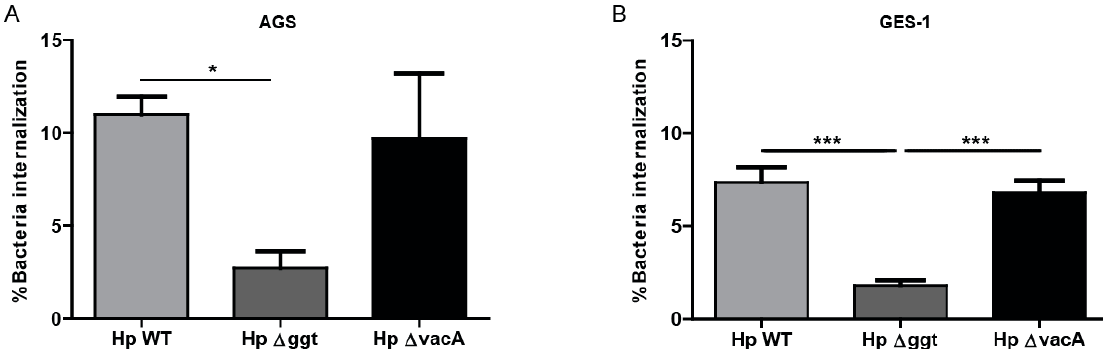
Figure 5. Loss of HpGGT decreases H. pylori internalization in gastric cells. AGS and GES-1 cells were infected with H. pylori wild type (HpWT) and the isogenic mutants Hp ∆ ggt and Hp ∆ vacA (lacking gamma-glutamyltranspeptidase and vacuolating toxin, respectively) at a multiplicity of infection (MOI) of 100 for 6 h. H. pylori internalization was evaluated using the colony unit forming assay. After infection, cells were treated with gentamycin (200 μ g/mL) for 1 h in order to eradicate extracellular bacteria. The percentage of intracellular viable H. pylori is shown. These data represent the mean ± the standard error of the mean (SEM) of three independent experiments. * p < 0.05, ** p < 0.01, *** p < 0.001.